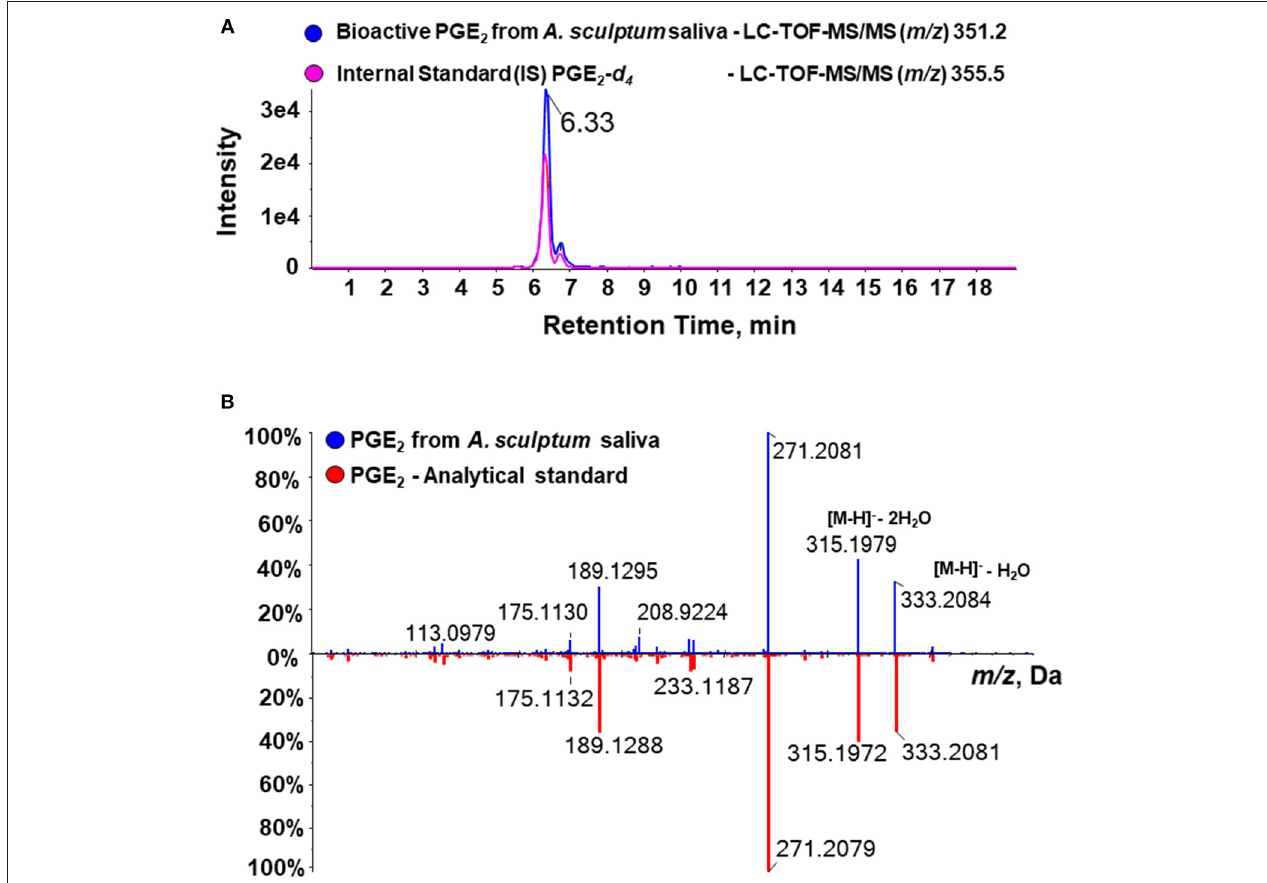
FIGURE 3 | Target high-resolution sequential mass spectrometry for lipids confirms the molecular identity of PGE 2 from A. sculptum saliva. Eicosanoids of A. sculptum saliva (collected by pilocarpine stimulation from female ticks fed on host for 7–9 days) and of saliva fractions were extracted and evaluated in an eisosanomics platform. (A) Chromatogram of LC-MS/MS (MRM HR mode) of an internal standard (PGE 2 - d 4 – pink line) and the target bioactive PGE 2 (blue line) showing the same retention time. (B) Comparative fragmental spectrum in high-resolution of PGE 2 from A. sculptum saliva (blue line) and a commercial PGE 2 standard (red line) showing nearly identical m/z